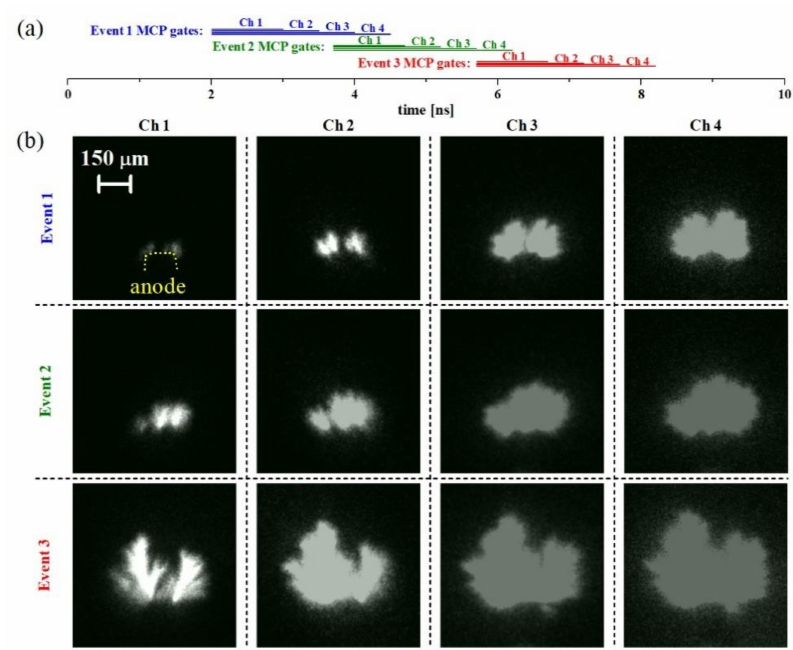
Figure 8. Case study B; image sequences obtained with broadband discharge emission. Horizontal bars in ( a ) labelled as Ch1–Ch4 illustrate the timing of the Ch1–Ch4 MCP gates with respect to the onset (time t = 0 ns) of the HV pulse. Images in panel ( b ) show the evolution of selected events during the primary HV pulse acquired by using the Ch1, Ch2, Ch3, and Ch4 MCP gates of 1, 1.5, 2, and 2.5 ns, respectively.